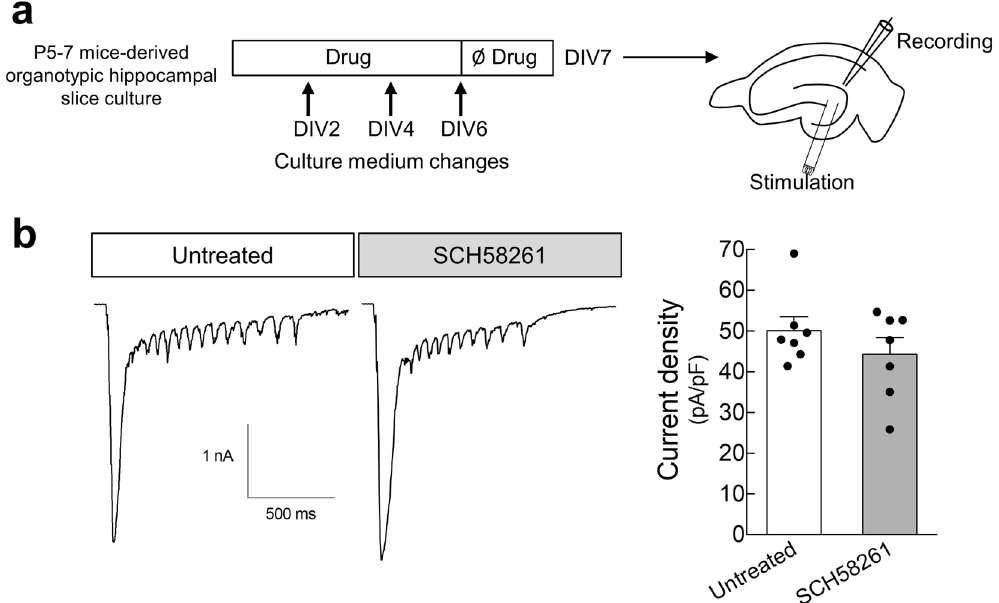
Figure 2. Pharmacological blockade of A 2A Rs does not modify the spontaneously-formed mossy fiber recurrent pathways in hippocampal organotypic slices. ( a ) P5-7 mice-derived hippocampal organotypic slices were cultured either in the absence or in the presence of SCH58261 (50 nM) until DIV 6, and at DIV 7 synaptic currents at dentate granule cells elicited by stimulation of mossy fibers at the hilus were recorded by whole-cell patch-clamp. ( b ) SCH58261 did not significantly modify the density of synaptic current in dentate granule cells upon stimulation at the hilus, as depicted in the representative traces and summarized in the histogram.